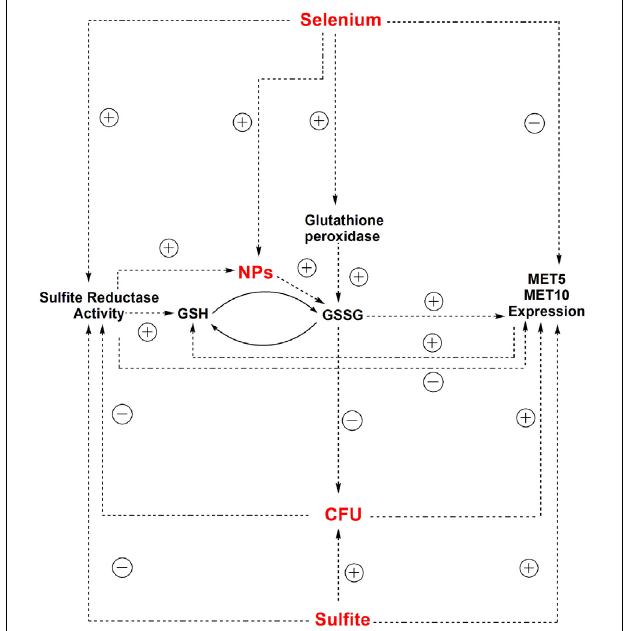
FIGURE 5 | The correlation between independent parameters (selenium and sulfite) and dependent parameters (CFU counts, MET5 / MET10 expression, and sulfite reductase activity) and other relationships between dependent and independent parameters in experimental condition of NPs